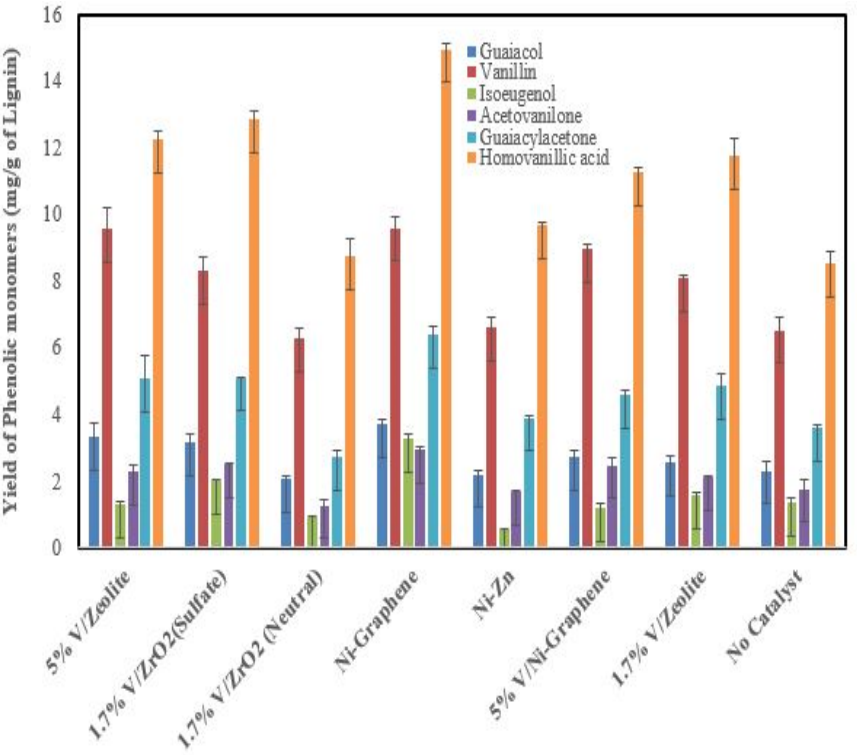
Figure 4. Yield of the major phenolic monomers from alkali lignin in presence of different type of catalysts at 240 °C for 10 min.